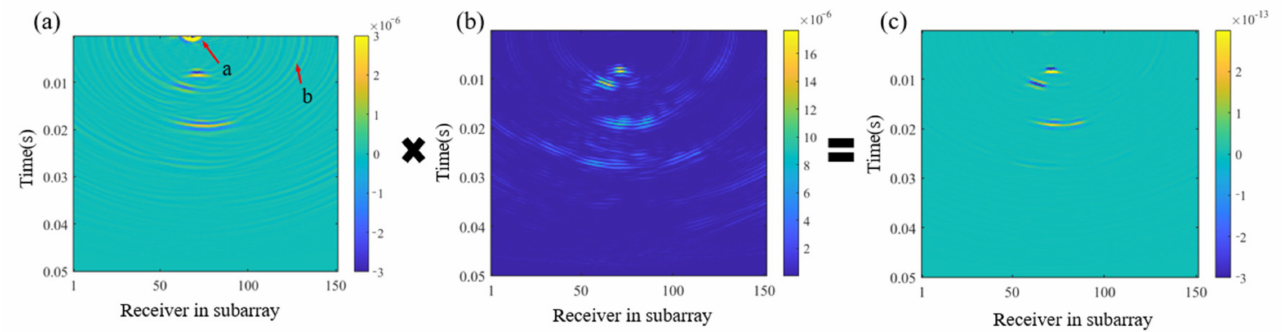
Figure 5. Preliminary image multiplied with the CF matrix to obtain the time-domain image of one shot. ( a ) Preliminary image. ( b ) CF matrix. ( c ) Image result of the 10th